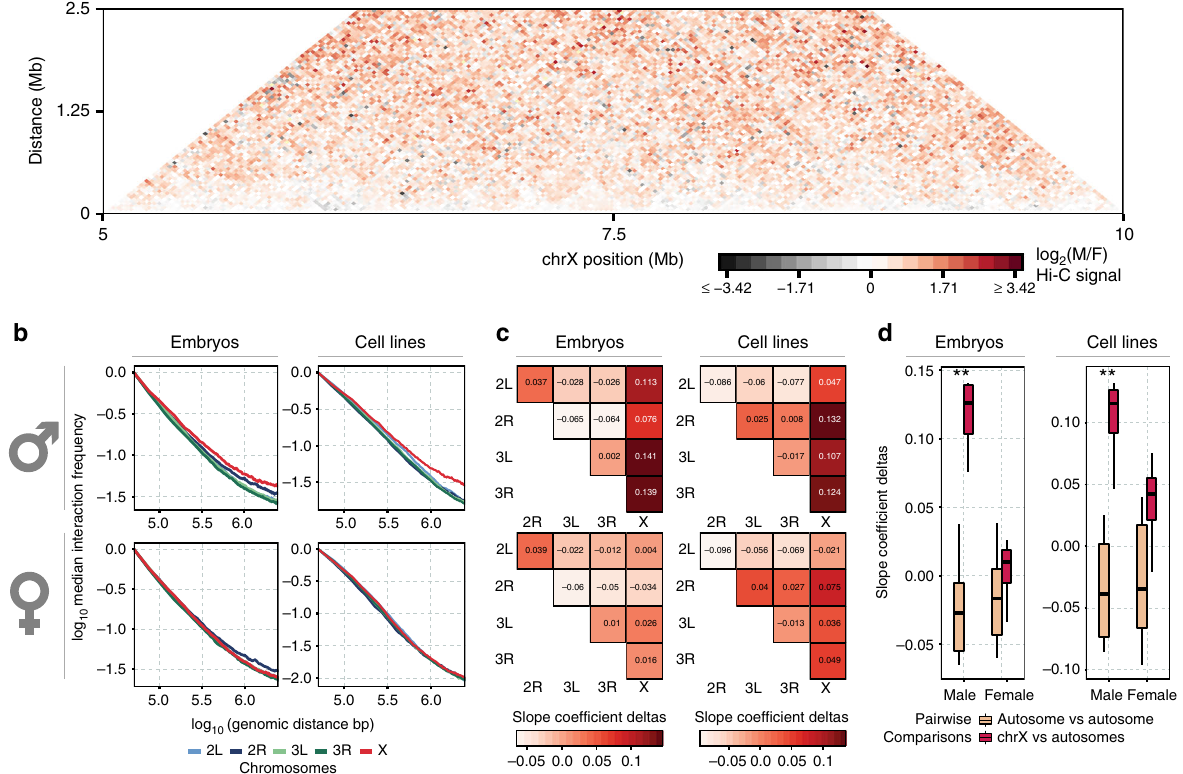
Fig. 1 Higher interaction frequency at mid-/long-range distances in male chrX. a Male over female log 2 ratio of normalized (chromosome-wise ICE) Hi-C matrices of contact frequencies binned at 25 kb resolution is shown for a representative 5 Mb region of chrX. b Interaction frequency decay with distance is shown in a log – log plot. Normalized (genome-wide ICE) Hi-C data binned at 25 kb were converted to contact frequencies as described in Methods for both sex-sorted embryos (left column) and cell lines (right column) datasets, for male (clone-8, upper row) and female (Kc167, lower row) samples. For any given genomic distance (log 10 genomic distance on x -axis) the median log 10 Hi-C interaction frequency is reported ( y -axis). Distances ranging from 50 kb (2 bins distance in the 25 kb bins matrix) to 2.5 Mb are shown. c Heatmap showing the pairwise difference (deltas) of the rate of Hi-C signal decay (slope coef fi cient). The slope coef fi cients were computed considering distances <400 kb ( ≤ 5.6 in log 10 distance). The colour scale and the numeric values report the differences between chromosomes indicated in the horizontal vs vertical axes labels. Layout as in ( b ) panel (male samples in upper row, female samples in lower row). d Boxplot of slope coef fi cient deltas for rate of Hi-C decay grouped by autosome pairwise comparisons (the fi rst three columns in panel ( c ) heatmaps) and chrX comparisons to autosomes (the fourth column in panel ( c ) heatmaps) in male and female embryos (left) or cell lines (right). The difference in rate of decay between autosomes and chrX is highly signi fi cant in male samples only (** marks Wilcoxon test p -value < 0.01). For each box the median is marked as horizontal line, the boxes mark the interquartile range (IQR), the whiskers extend up to 1.5